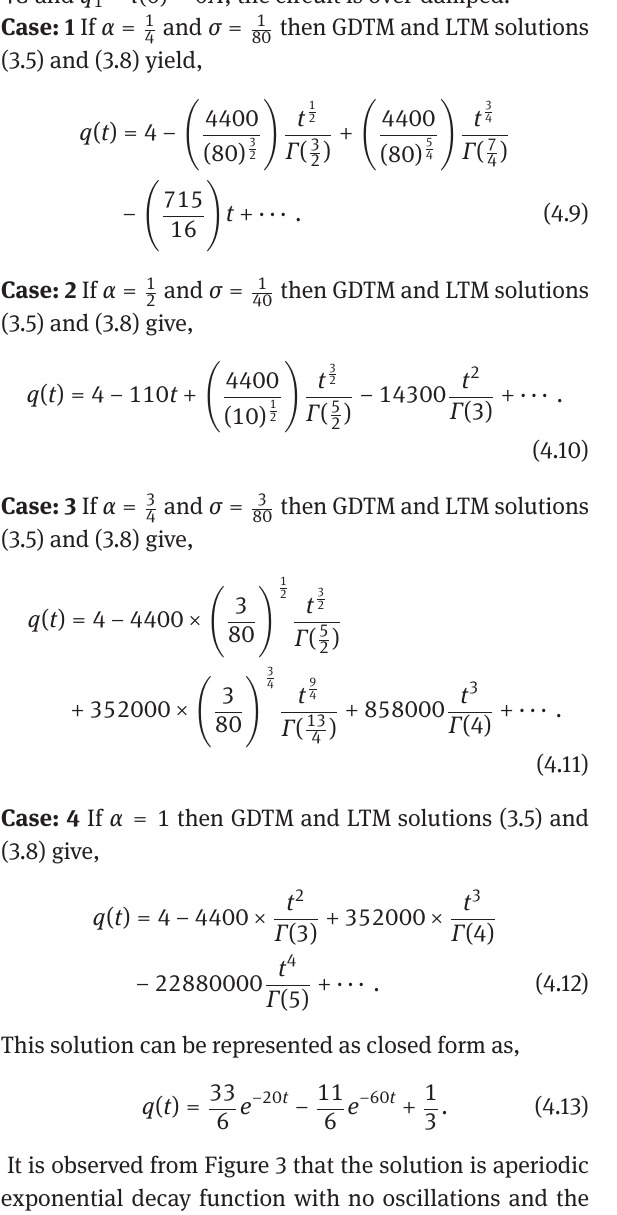
Fig. 2: The underdamped response of the circuit when L = 0.25 H , R = 10 Ω , C = 0.001 mF , q 0 = 2 C , q 1 = i (0) = 0 A